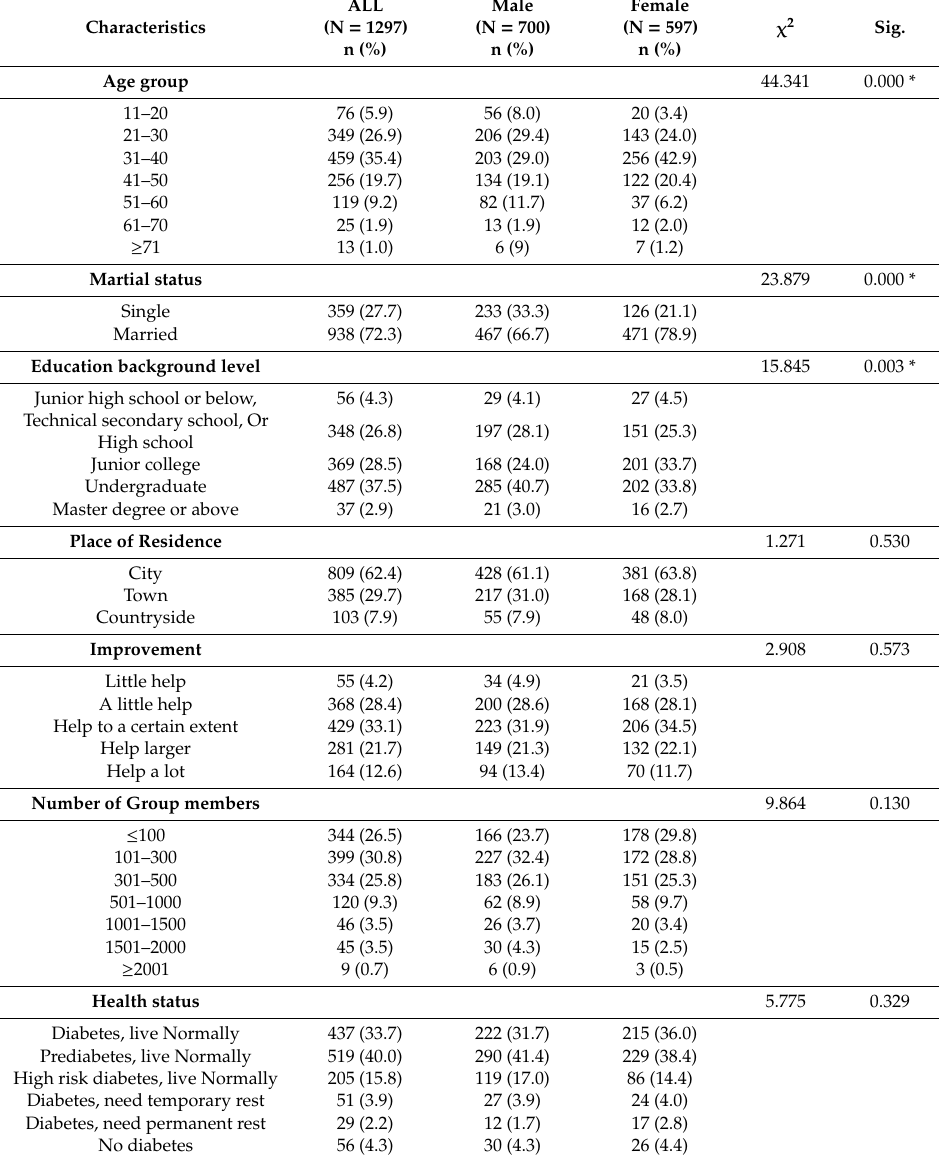
Table 1. Chi-square result of basic information between male and